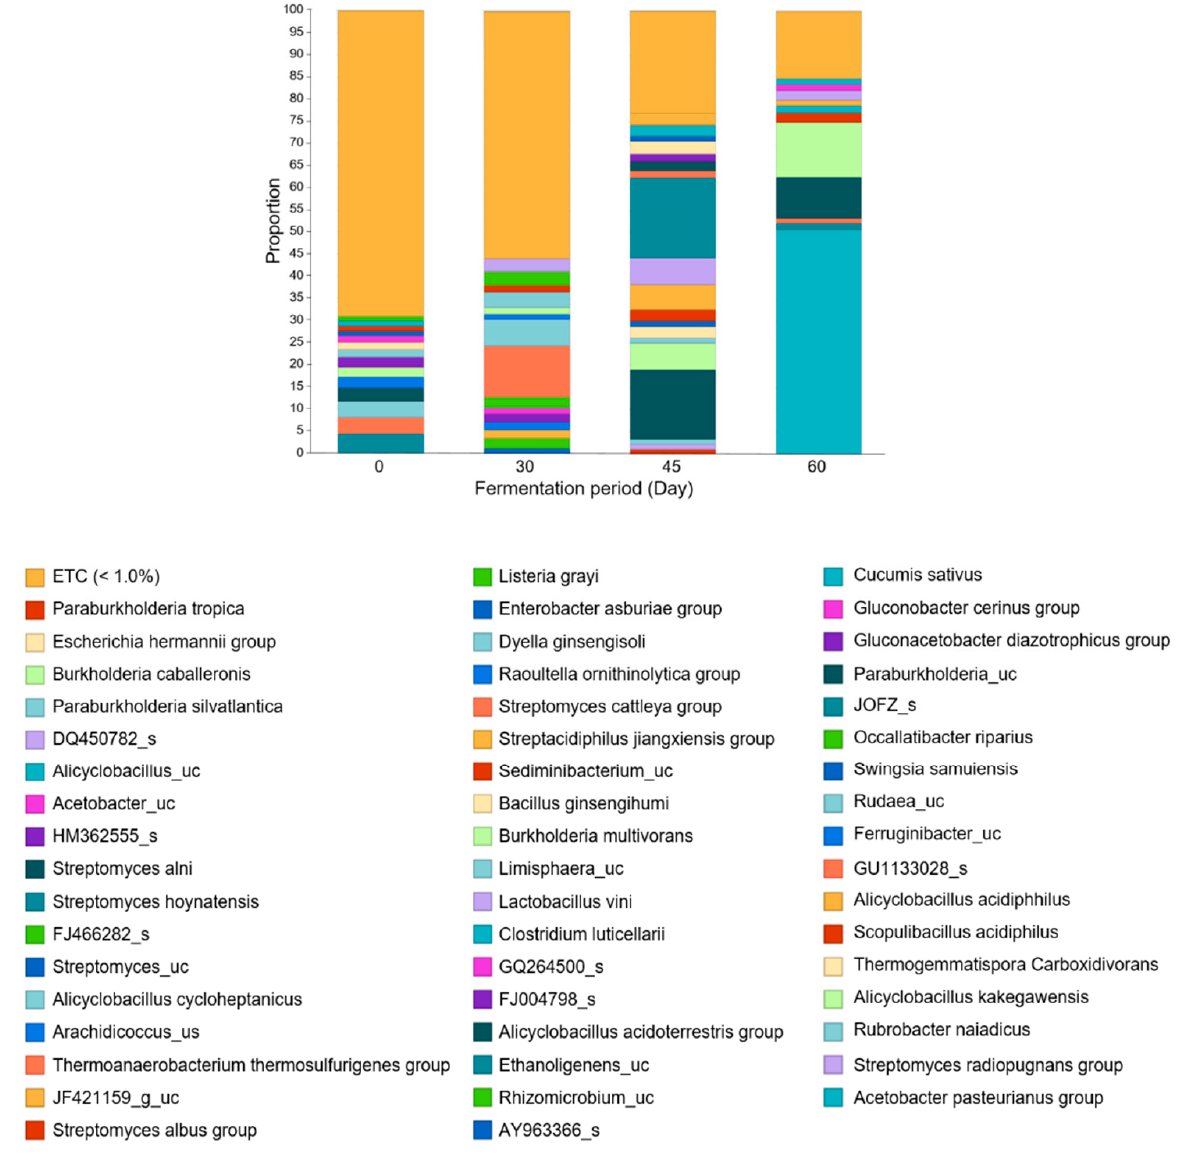
Figure 6. Taxonomic classification of microbial reads retrieved from 0, 30, 45, 60-day fermented oak tree sawdust using the EzTaxon database. Microbial analysis of 0, 30, 45, and 60-day fermented oak tree sawdust conducted using a 454 GS FLX titanium next-generation sequencing (NGS) system (Roche, Branford, CT) according to the manufacturer’s instructions (Lee and Eom, 2016). The relative proportion of microbiota was displayed using an EzTaxon database. Each color indicates a unique species.